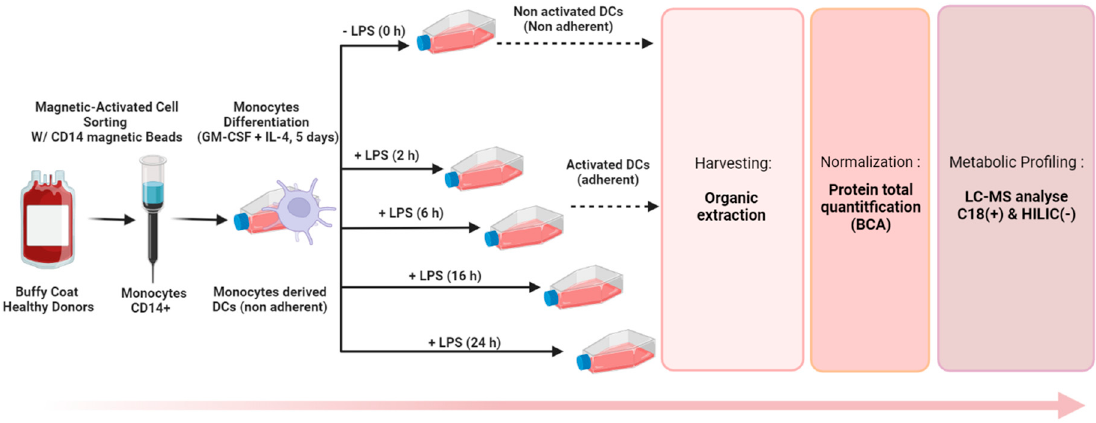
Figure 5. Optimized workflow for the untargeted metabolite profiling of DCs.